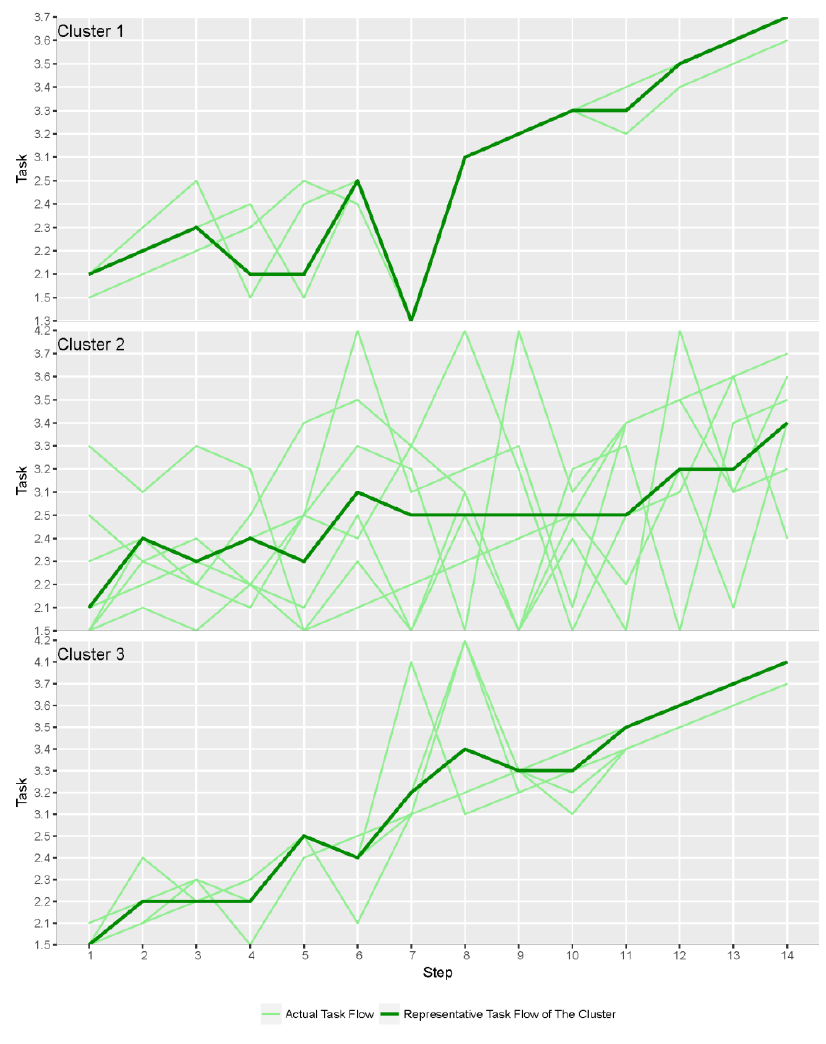
Figure 6. Curve Clustering graphs (3 clusters).